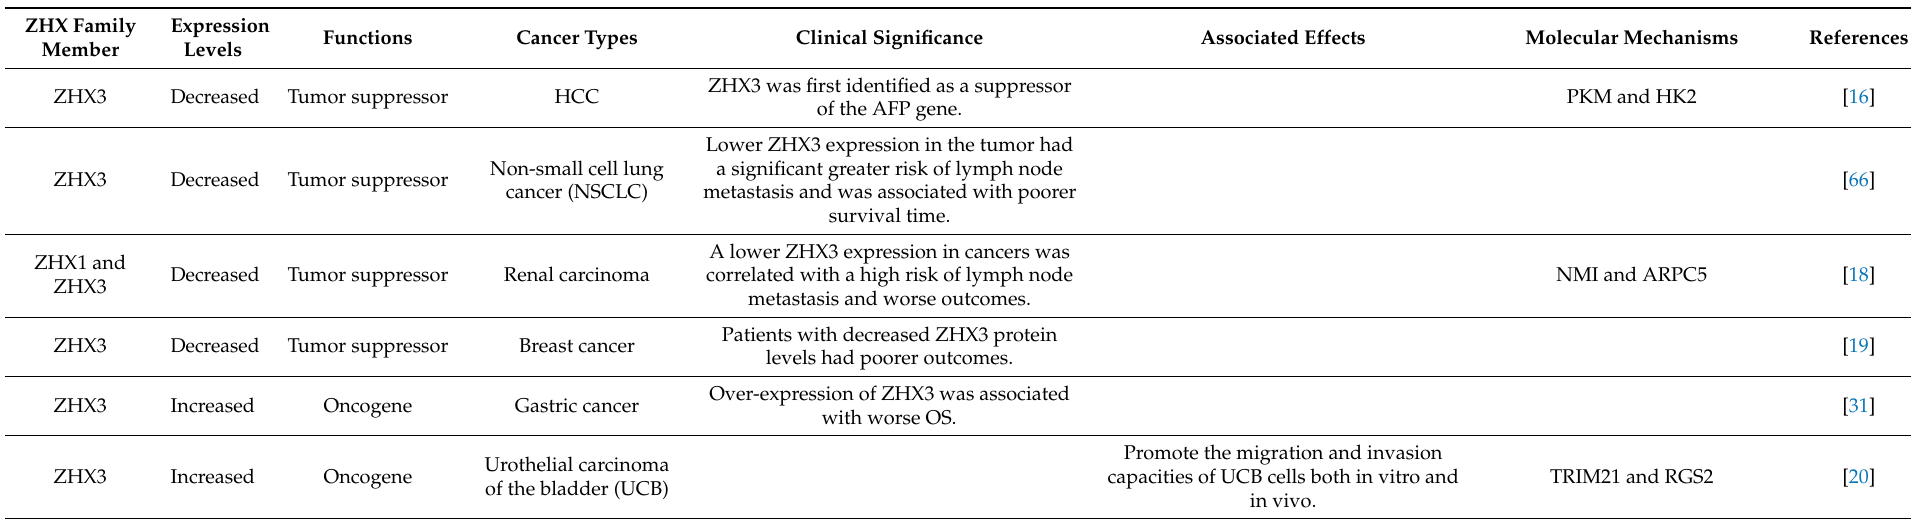
Table 3. Studies on ZHX3 expression, function, clinical significance, and molecular